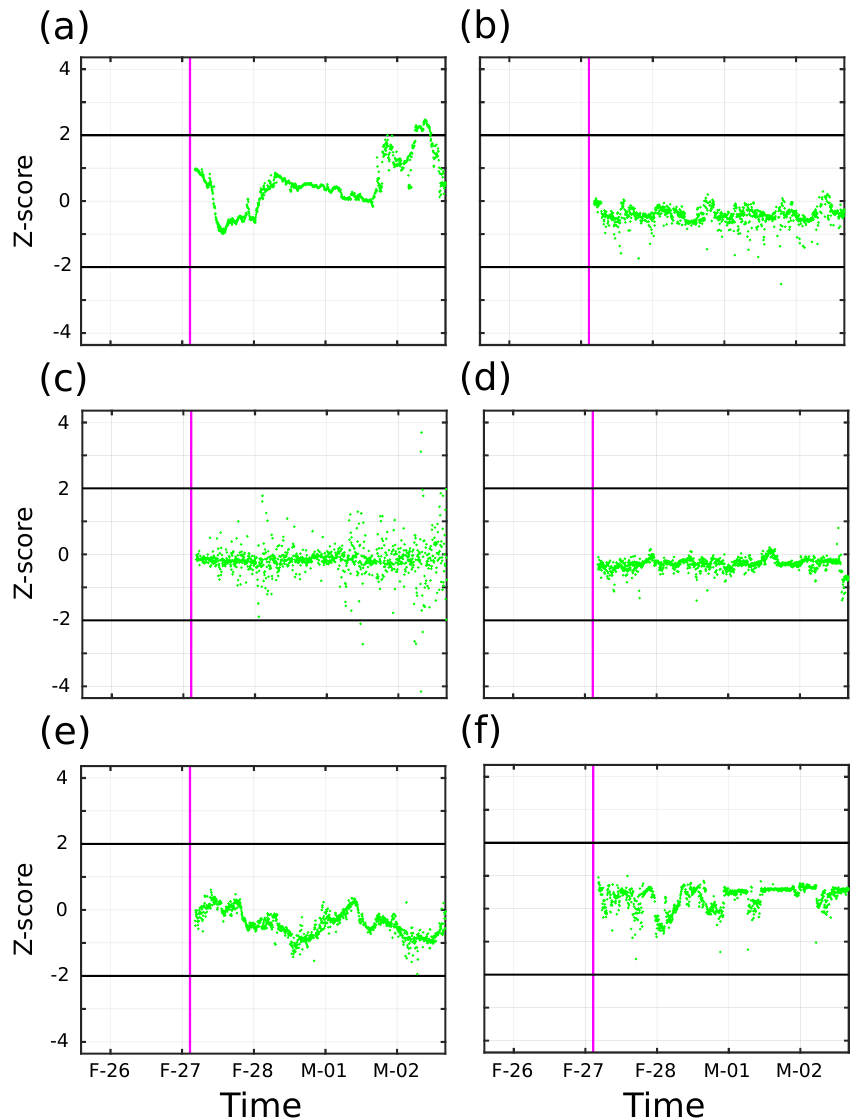
Figure 6. SedTrap drifter Z -score time series for (a) 14, (b) 55, (c) 88, (d) 105, (e) 137, and (f) 197m depth. End of inertial period timeframe for baseline definition plotted in magenta. Z = − 2 and 2 plotted in